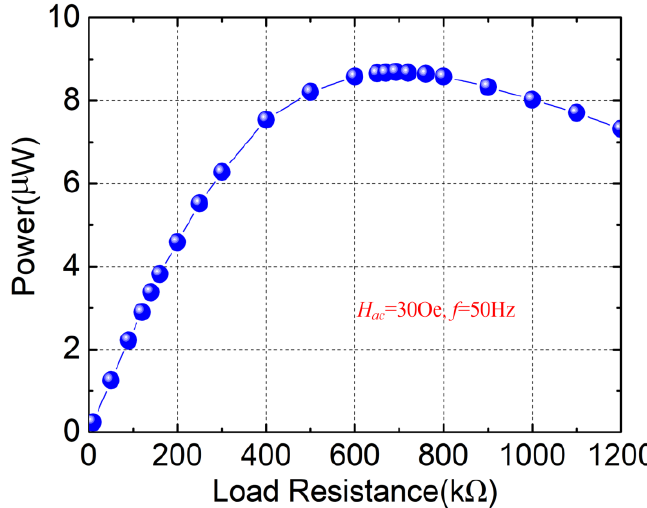
Figure 7. Output power versus load resistance under the alternating magnetic field of 30 Oe. Figure 8 plots the maximum output powers for various alternating magnetic fields.